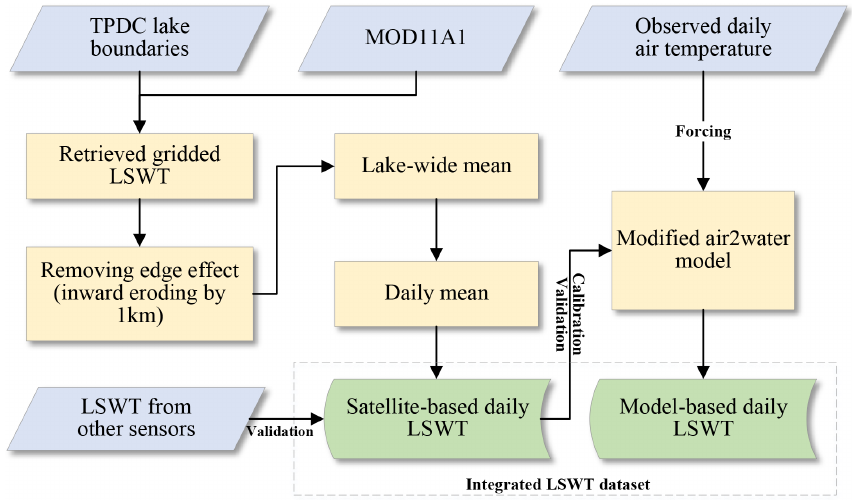
Figure 2. Framework for integrating lake surface water temperature (LSWT)